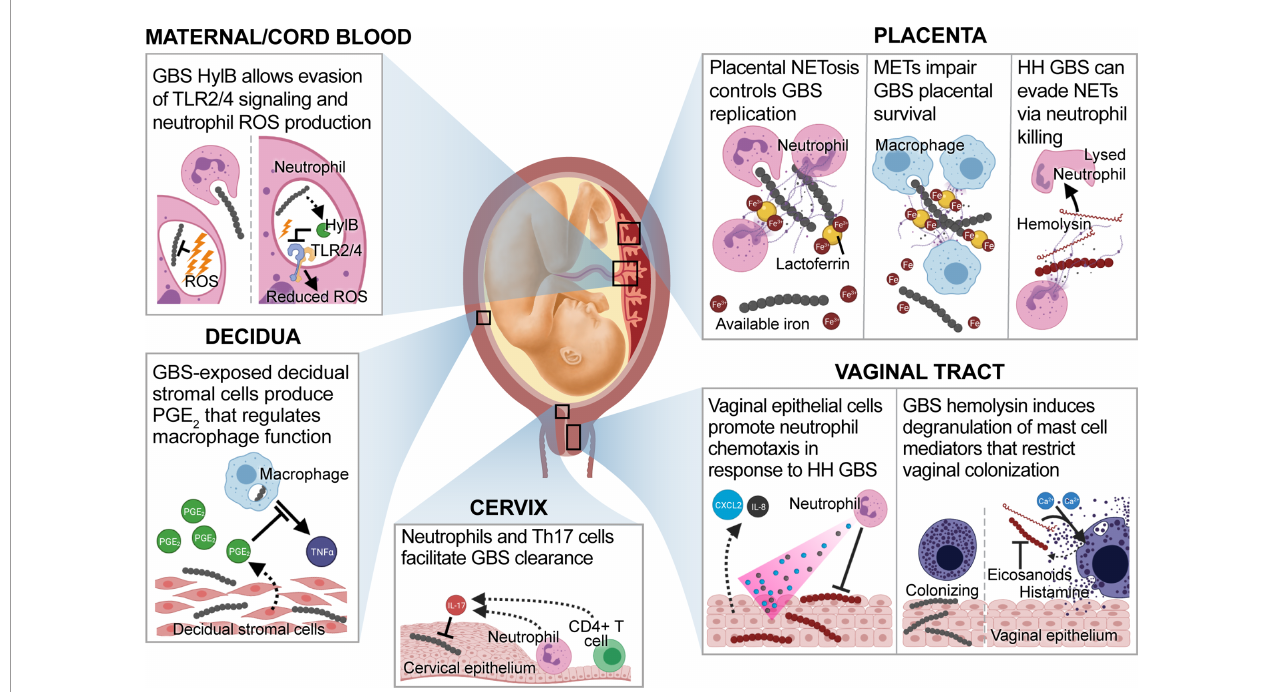
FIGURE 2 | GBS-directed host immune responses at the maternal-fetal interface. During GBS infection at the maternal-fetal interface, a variety of immune cell interactions can occur. In the vaginal tract, epithelial cells exposed to hyperhemolytic (HH) GBS secrete C-X-C motif chemokine ligand 2 (CXCL2) and interleukin (IL)-8 which mediate GBS elimination through the recruitment of neutrophils (Patras et al., 2013). Whereas wild-type GBS colonize the lower genital tract in the presence of mast cells, HH GBS induce mast cell degranulation in a hemolysin and calcium-dependent manner. This results in the release of pre-formed mast cell mediators, such as eicosanoids and histamine that mediate GBS clearance (Gendrin et al., 2015). During ascending infection, cervical Th17 cells that produce IL-17 are associated with GBS clearance (Patras et al., 2015). Decidual stromal cells exposed to GBS produce prostaglandin E 2 (PGE 2 ), which suppresses macrophage tumor necrosis factor alpha (TNF- a ) production (Rogers et al., 2018). Placental neutrophils produce neutrophil extracellular traps (NETs) that immobilize GBS and facilitate clearance via phagocytosis and nutritional immunity. NET-contained lactoferrin sequesters ferric iron (Fe 3+ ), resulting in GBS growth arrest (Kothary et al., 2017). HH GBS evade placental NETs by hemolysin-mediated killing of neutrophils (Boldenow et al., 2016). Macrophages control placental GBS replication through a similar mechanism, and macrophage extracellular traps (METs) contain similar products (Doster et al., 2018). Finally, neutrophils in maternal and cord blood phagocytose GBS and produce reactive oxygen species (ROS) to mediate bacterial killing. However, GBS expressing hyaluronidase (HylB) inhibit this mechanism by interfering with toll-like receptor 2 and 4 signaling. Downstream effects of this immune dampening suppress ROS production and facilitate GBS survival (Coleman et al.,